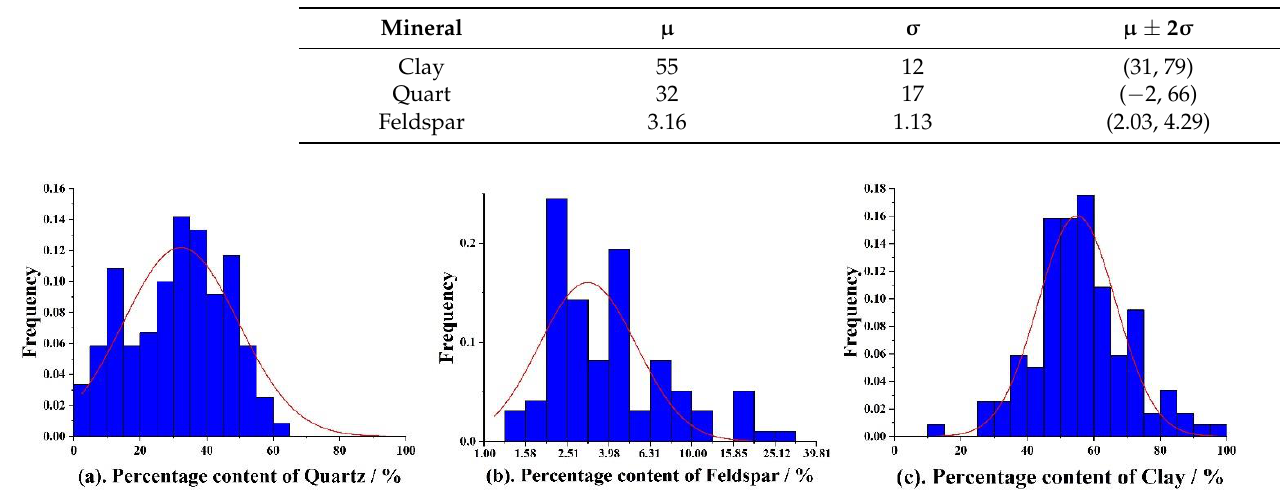
Figure 1. Distribution of mineral content fitting with Gaussian normal distribution. ( a ). Quartz content ranged from 0.9% to 62.7% of the weight composition. ( b ). Feldspar content varied from 0.4% to 27.5%. ( c ) Clay minerals varied from 14.3% to 97.4%.